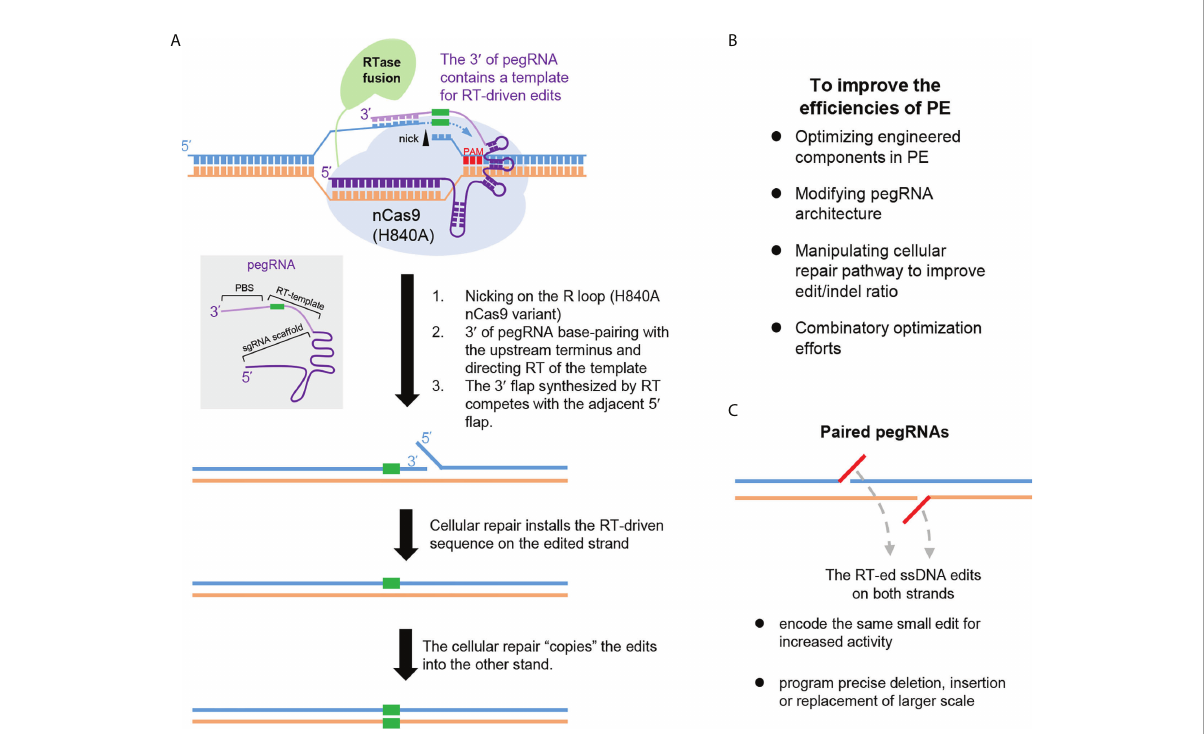
FIGURE 4 Prime editing. (A) The principle underlying the prime editor (PE) is illustrated. PE employs nCas9 (H840A) fused with a reverse transcriptase (RT) domain. PE is directed by pegRNA whose structure is schematically shown in a grey box. The pegRNA is composed of a targeting sgRNA scaffold and an extended 3 ′ region. This region can base pair with the nicked R-loop (via its terminal portion named primer binding sequence, PBS), and directs the ensuing reverse transcription (via its edits-containing segment named RT-template). The potential mechanistic stages underlying PE are depicted in order. (B) Major focuses for improving the PE ef fi ciencies are summarized. (C) The advantages of PE with paired pegRNAs are summarized. Note that each pegRNA would enable reverse transcription of a segment of ssDNA (indicated in red). Programming the paired pegRNA sequences would enable increased PE activities, or empower precise editing of larger